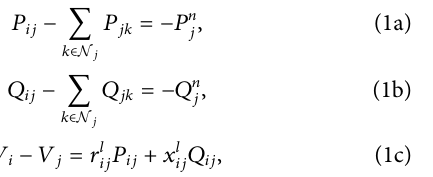
Frontiers in Energy Research |